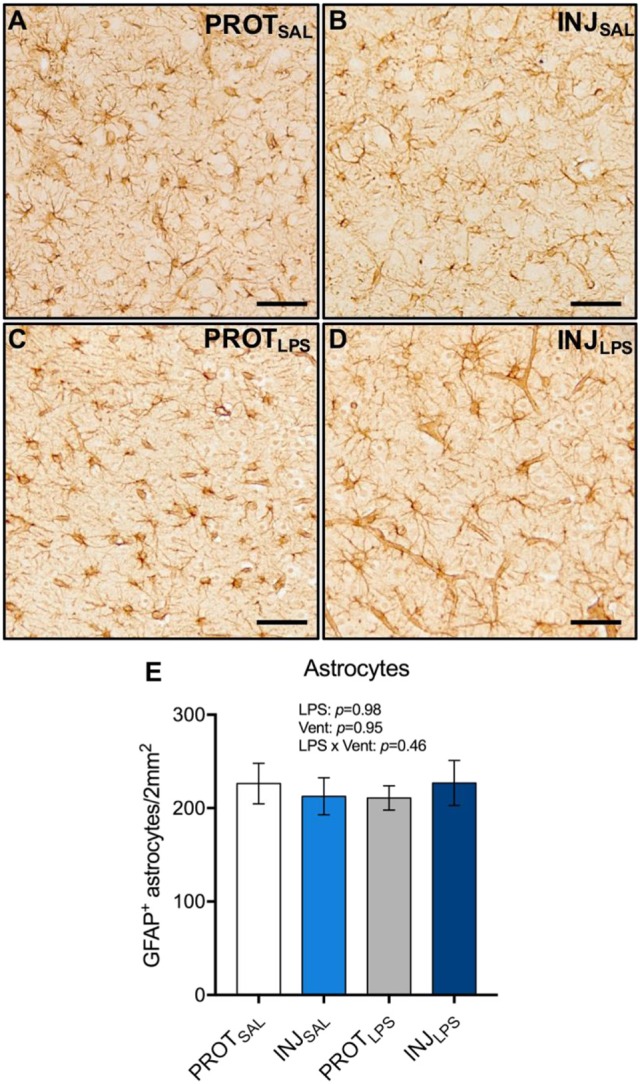
Ventilation strategy and LPS exposure does not alter astrocyte numbers in the cortical gray matter. Representative images of GFAP+ astrocytes in the gray matter (A–D). Neither ventilation strategy, or LPS exposure caused changes in the number of astrocytes (E). Magnification = 2x, scale bar = 20 μm. PROTSAL, N = 5; PROTLPS, N = 6; INJSAL, N = 6; and INJLPS, N = 5.